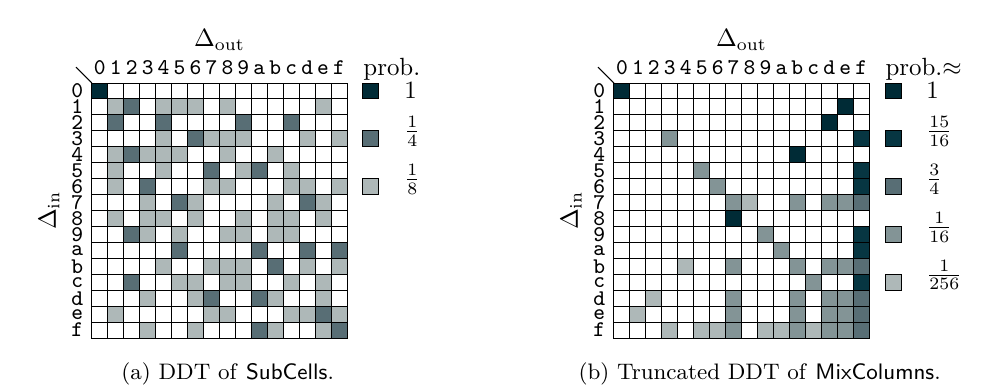
Figure 4: Differential distribution tables (DDT) of the MANTIS round